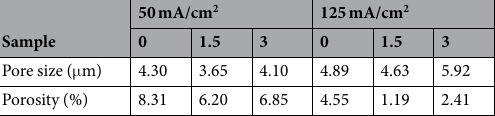
Table 1. Pore size and porosity of the PEO coatings formed on an Al-Mg-Si alloy by PEO for 8 min using different concentrations of